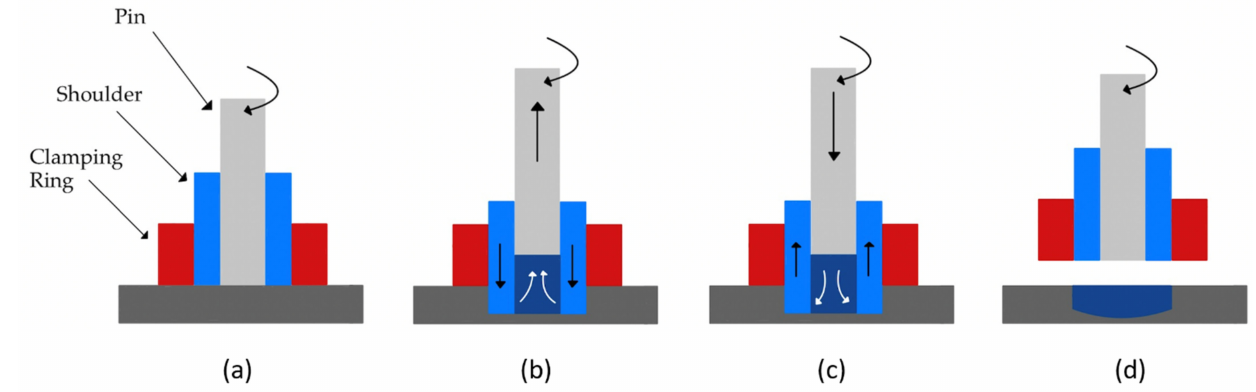
Figure 1. Schematic of the RFSSW process: ( a ) clamping phase, ( b ) plunging phase, ( c ) refill phase, and ( d ) retraction